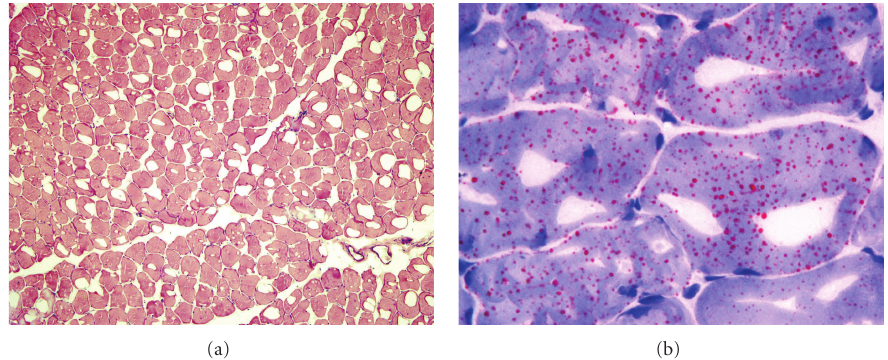
Figure 1: (a) H&E stained frozen section of the muscle biopsy showing normal architecture ( × 100). (b) Oil Red-O method, which is used for highlighting neutral triglycerides and lipids in frozen sections, showed several orange-red-stained droplets of lipids, a finding consistent with the clinically suspected diagnosis of lipid storage disease ( ×